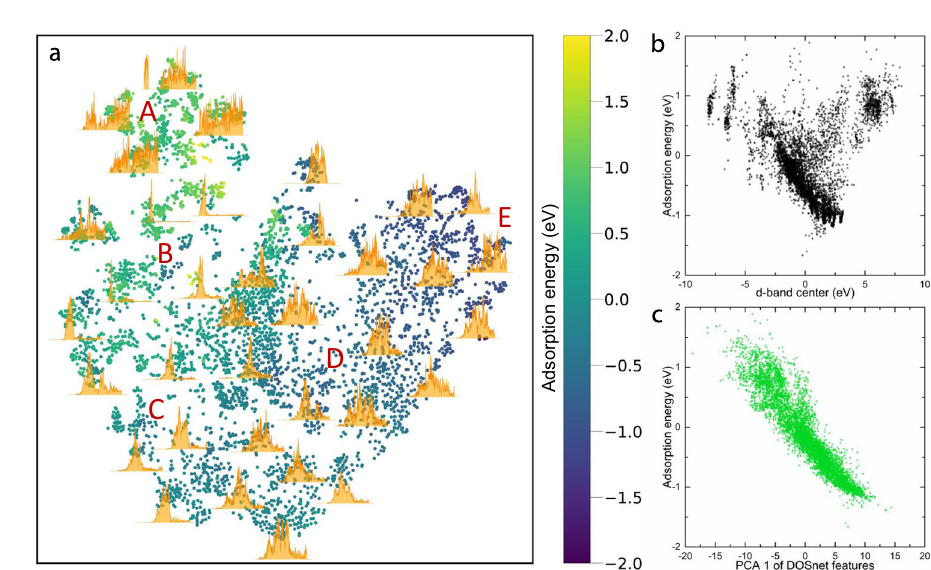
Fig. 5 Visualization of DOS feature space and correlation to adsorption energy. a t-SNE plot of DOS features obtained from the last convolutional layer of DOSnet for the case of hydrogen adsorption. Points represent unique surface sites and are colored by the adsorption energy of that site. Selected DOS from these sites are plotted. b Plot of d -band center versus hydrogen adsorption energy. c Plot of the fi rst component of the DOS features from a principal component analysis versus hydrogen adsorption